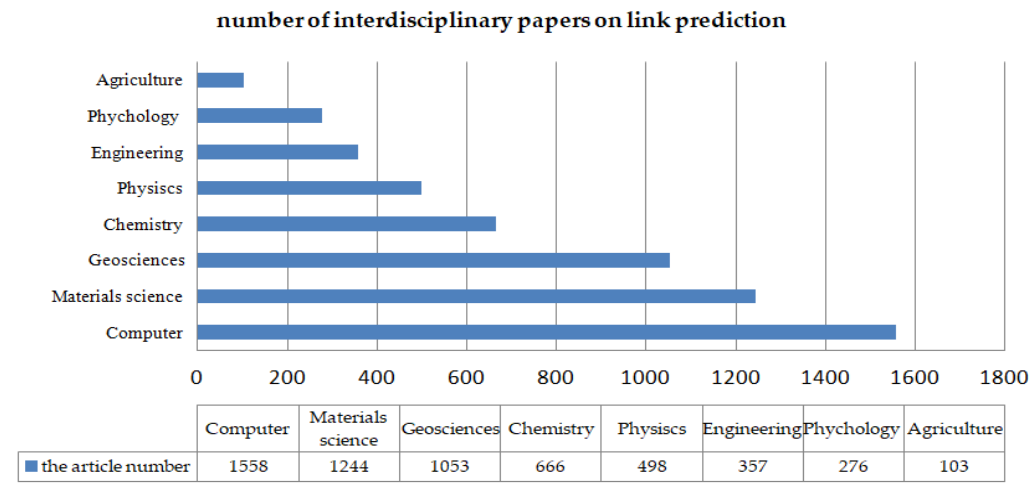
Figure 4. Number of interdisciplinary papers on link prediction.